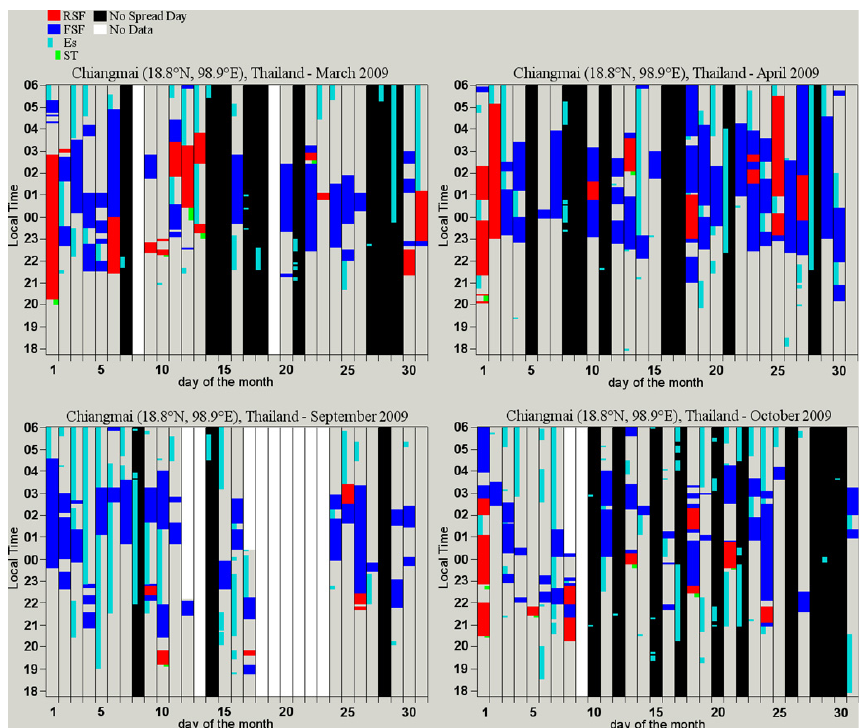
Fig. 5. RSF (red), FSF (blue), satellite trace (green), and blanketing Es layer (cyan) occurrences at Chiangmai, Thailand, from 18:00LT to 06:00LT, for March, April, September, and October 2009. White means data unavailability. Black highlights no spread-F days.